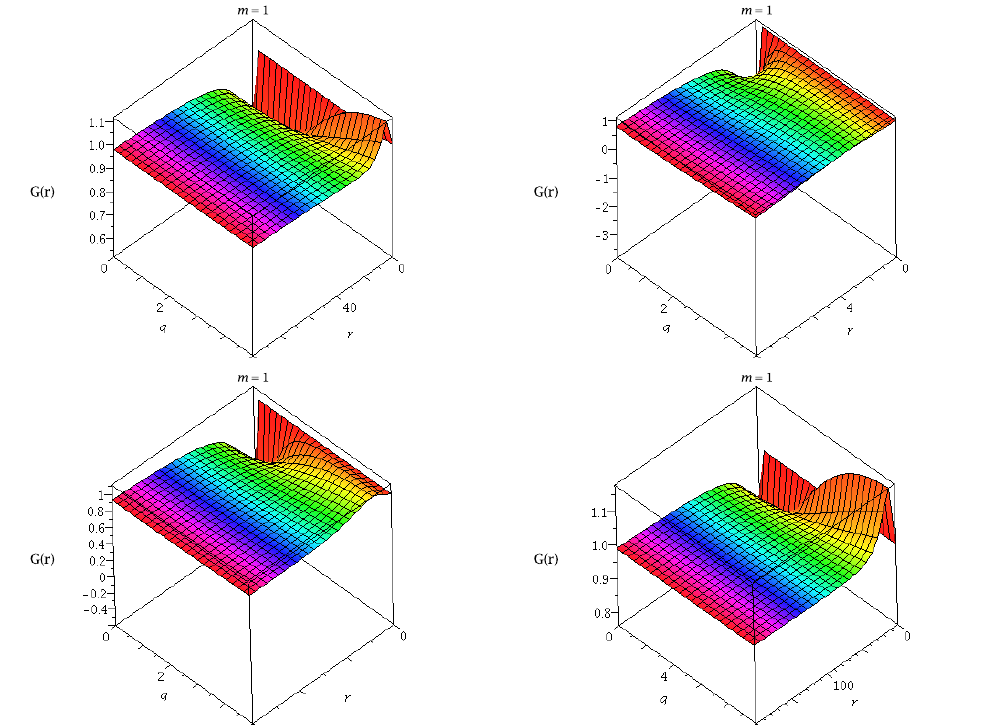
Figure 1. The figure shows the variation of G ( r ) with r for different values of q